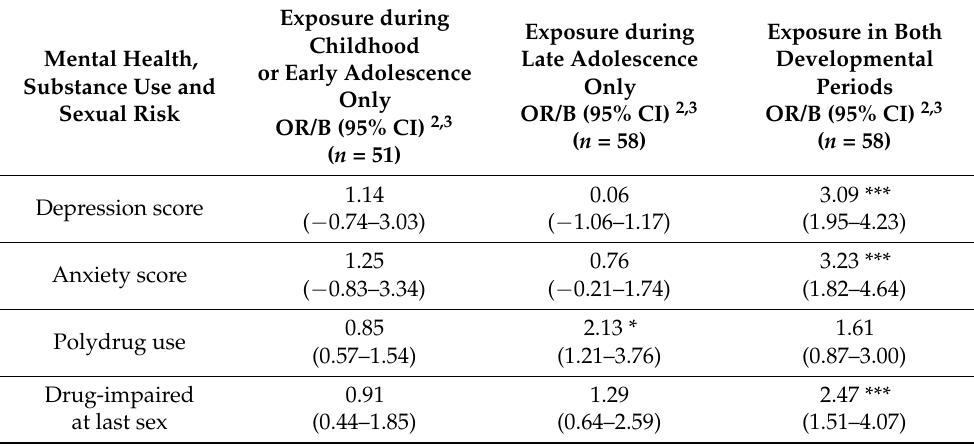
Table 3. Relationship between developmental period of abuse and risk of common mental disorders among young women who use substances in Cape Town, South Africa ( n = 499) 1